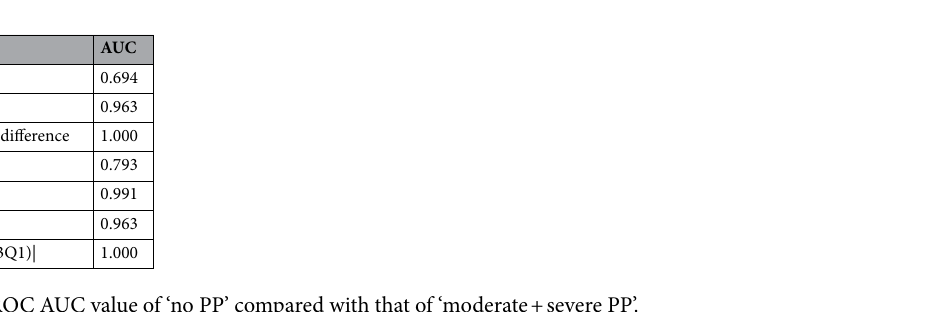
Table 3. ROC AUC value of ‘no PP’ compared with that of ‘moderate + severe